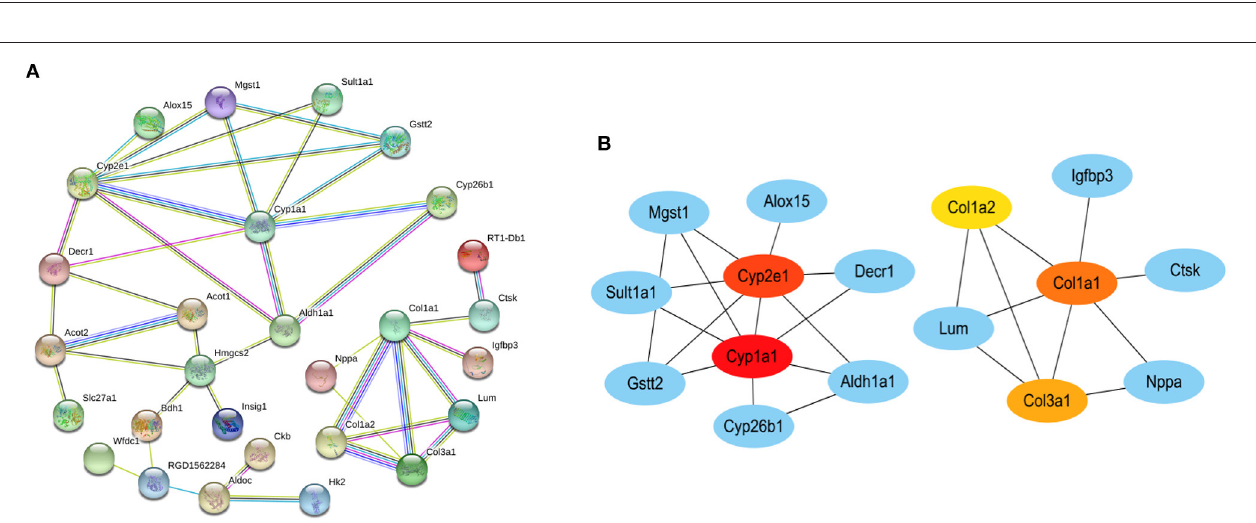
FIGURE 5 | The protein–protein interaction (PPI) networks. (A) PPI network of common DEGs in datasets GSE4745 and GSE6880. (B) PPI network containing the first five hub genes obtained by cytoscape. The color of the node reflects the degree of connection. The more forward ranking is represented by a redder color. Red represents the highest level. Orange represents the middle level. Yellow represents the lowest level.